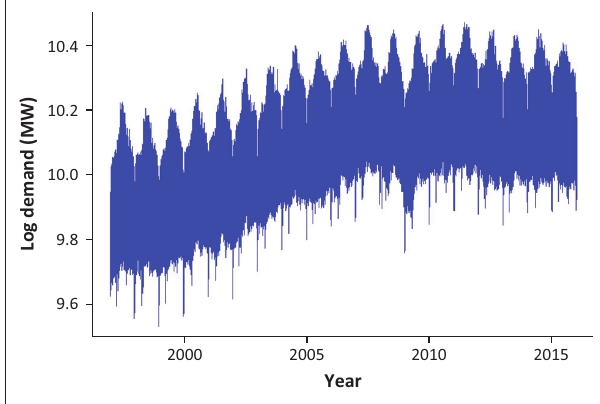
FIGURE 2: Adjusted electricity demand between 1997 and 2015 in South